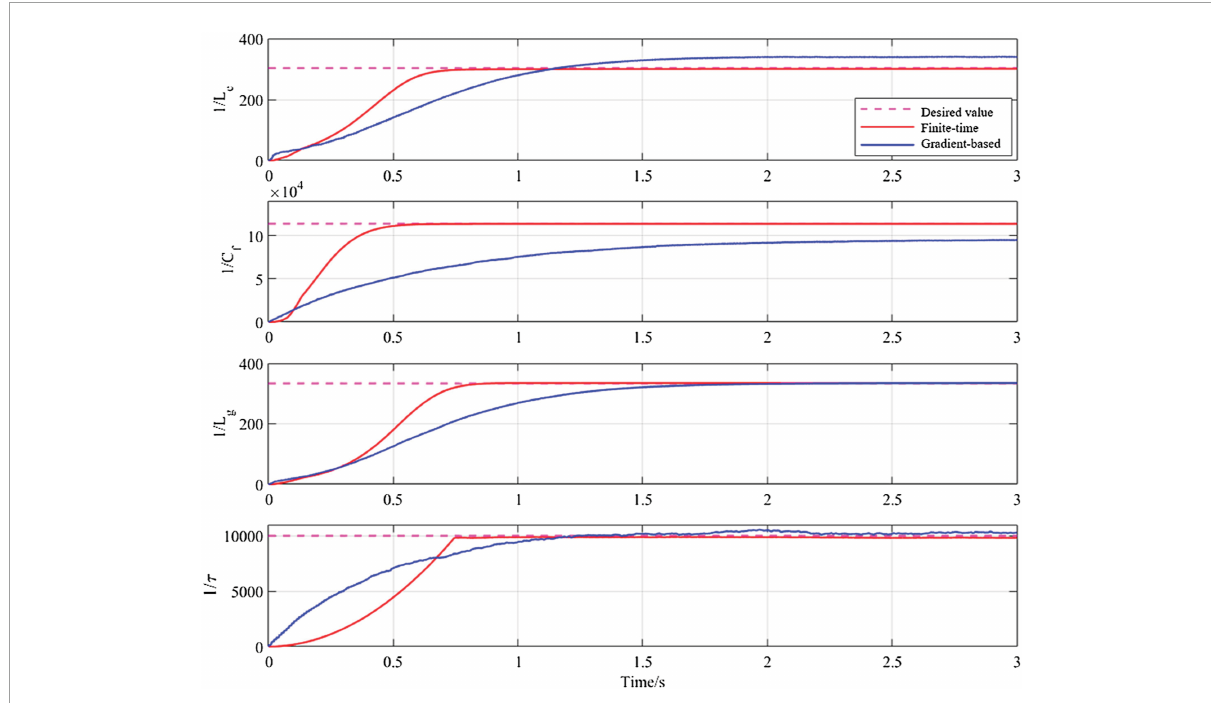
FIGURE 4 Parameter estimation compared with the proposed method and gradient-based method.